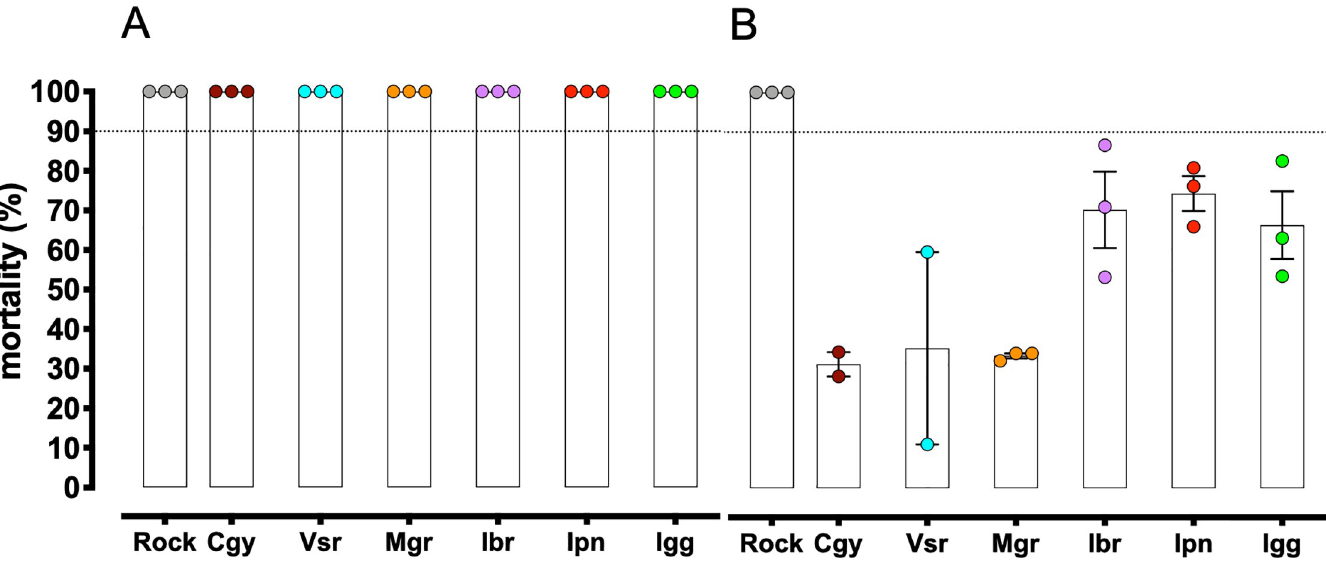
Fig 4. Mortality of Aedes aegypti from RJ populations exposed to the adulticides: (A) organophosphate malathion (20 μ g/bottle) and (B) pyrethroid deltamethrin 0.05%. We used Rockefeller (Rock) as the susceptible reference. Dots represent the mean mortality of each performed bioassay with total mean and SEM error bars.